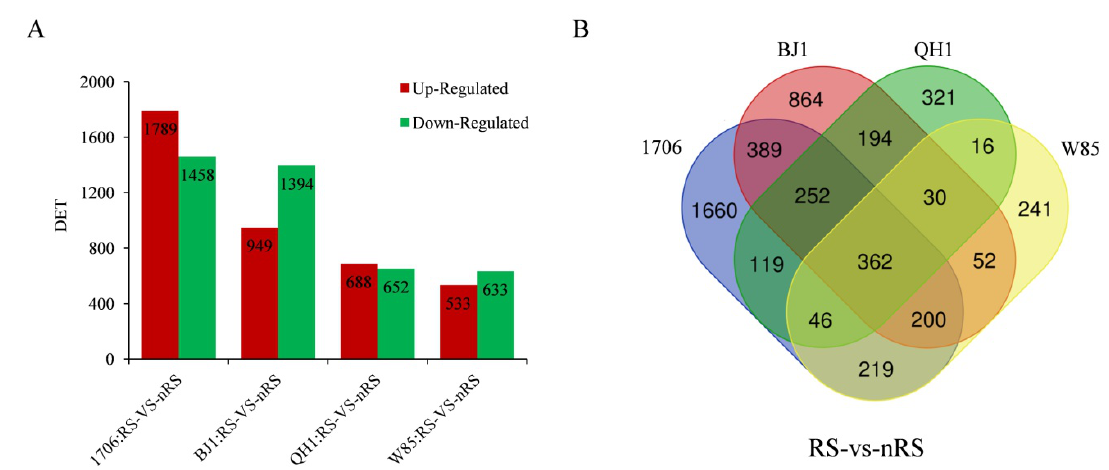
Figure 4. Unigenes significantly differentially expressed between radial striation and non-radial striation in different R. glutinosa cultivars. ( A ), The up-regulated and down-regulated transcript numbers in radial striation and non-radial striation. X axis represents pairwise and Y axis means number of screened DETs. Green bar denotes down-regulated genes and red bar for the up-regulated. ( B ), Venn diagram analysis of the quantity of DETs identified in radial striation and non-radial striation.